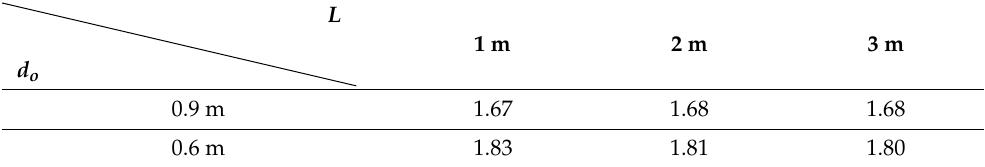
Table 2. The drag coefficient for the building model in the absence of the mitigation wall.